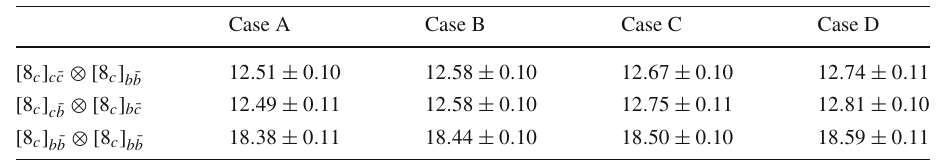
Fig. 1 The [ 8 c ] c ¯ c ⊗[ 8 c ] c ¯ c tetraquark masses M X as a function of the Borel parameter M 2 to D stand for cases A to D , and the two vertical lines in each case indicate the upper and lower bounds of the valid Borel window with the central √ s 0 value of Table 1 The windows of the Borel parameter, continuum thresholds, pole contributions, two-gluon contributions, and predicted masses for [ 8 ] ⊗ [ 8 ] c c ¯ c c c ¯ c tetraquark states